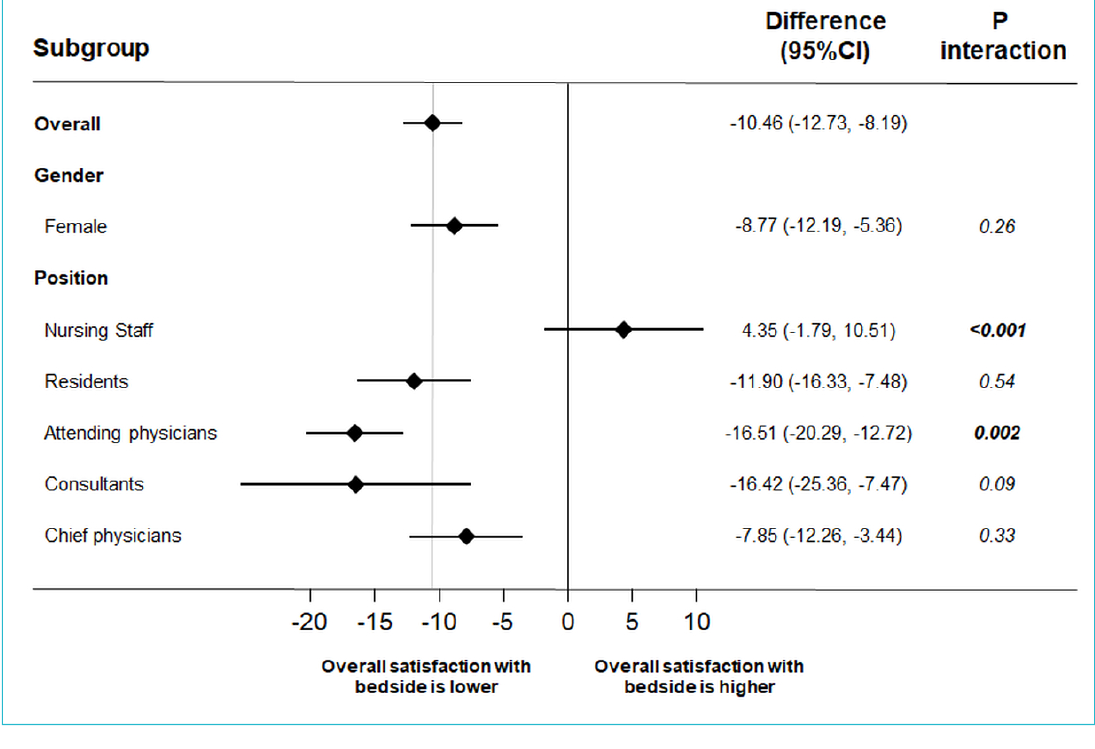
Figure 1: Satisfaction with ward rounds in different subgroups. All differences calculated with multivariate linear regression models for continu- ous data.